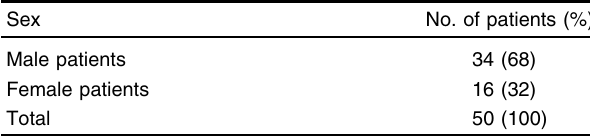
Table 1 Sex distribution of patients